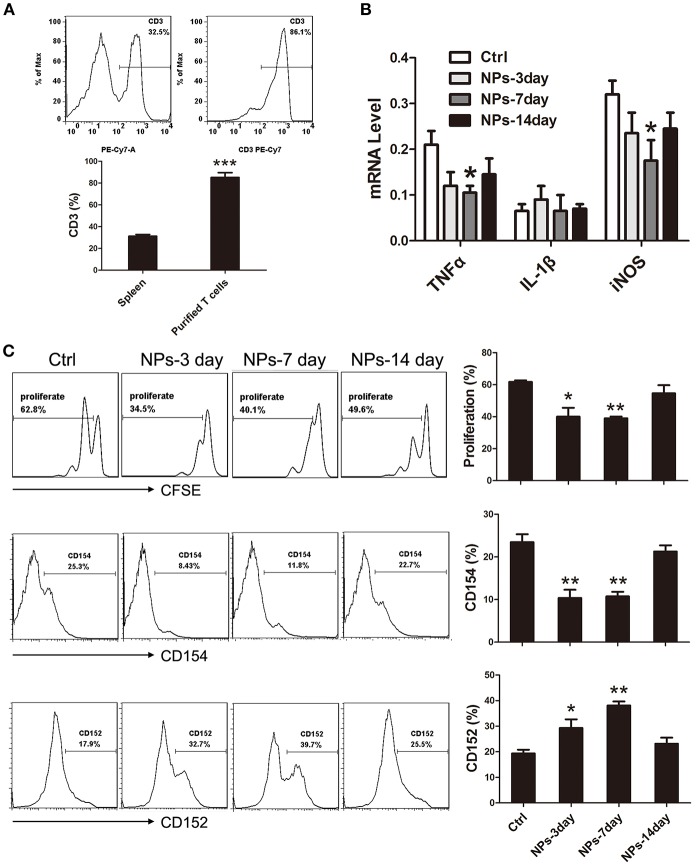
(A) Extraction of T lymphocytes from nanoparticles-treated mice. (B) Expressions of pro-inflammatory factors of BV-2 microglia cells (IL-1β, TNF-α, and iNOS). (C) FACS analysis of CFSE and CD152, CD154 in cultured T cells. *compared with Ctrl, P < 0.05, **compared with Ctrl, P < 0.01.